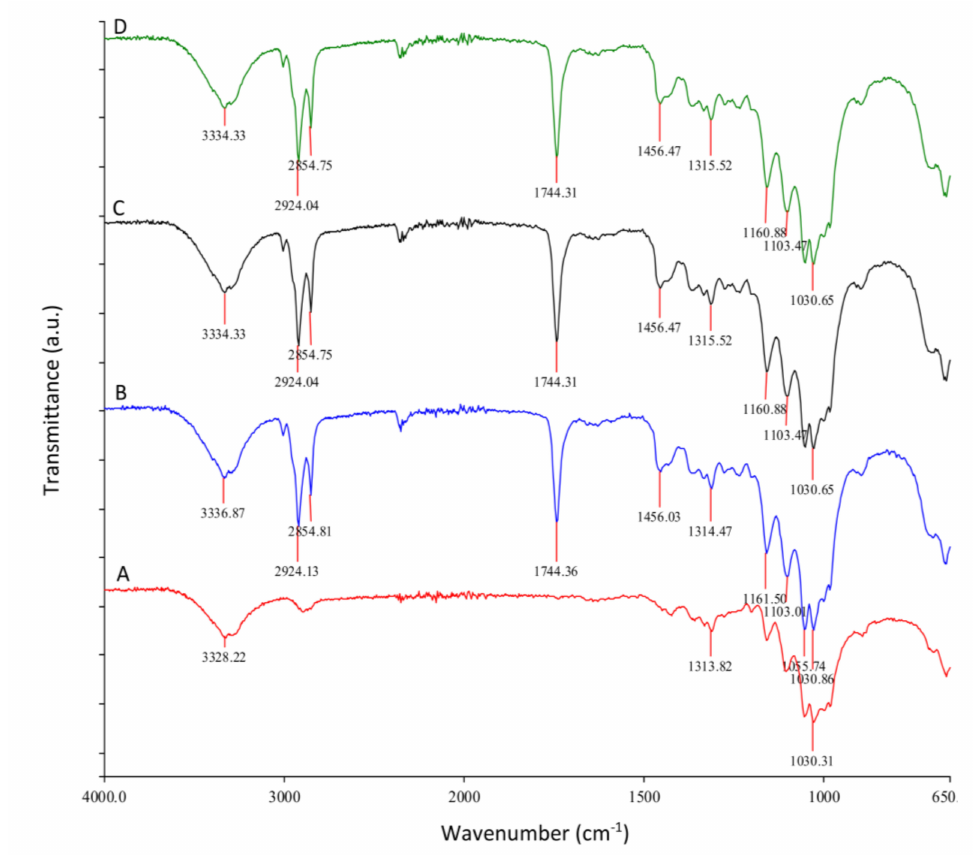
Figure 2. ATR FTIR spectrum of non-treated cotton tampon ( A red); spectrum of cotton tampon treated with CBD oil only, recorded on outer side ( B blue); spectrum of cotton tampon treated with CBD oil only, recorded on inner side ( C black); and spectrum of CBD oil as reference ( D